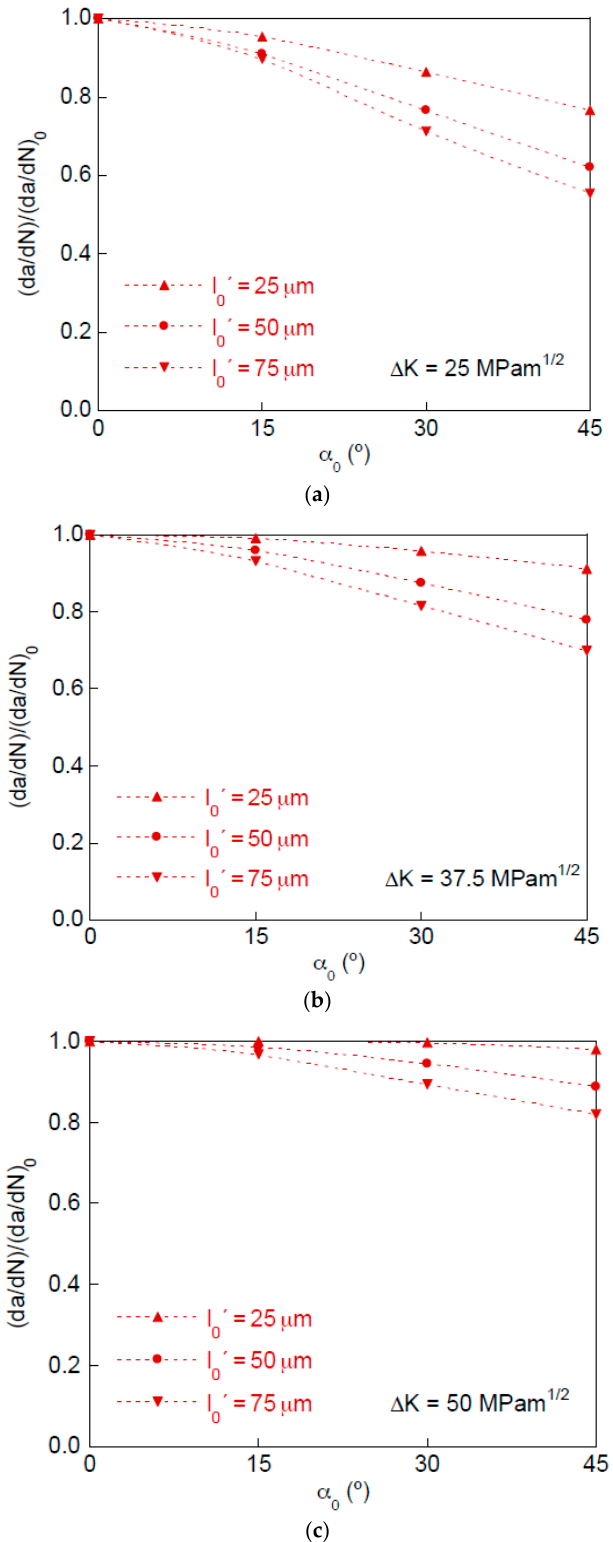
Figure 6. Retardation factor of the fatigue crack growth rate for the kinked crack tip: ( a ) Δ K = 25 MPam 1/2 ; ( b ) Δ K = 37.5 MPam 1/2 ; and ( c ) Δ K = 50 MPam 1/2 .